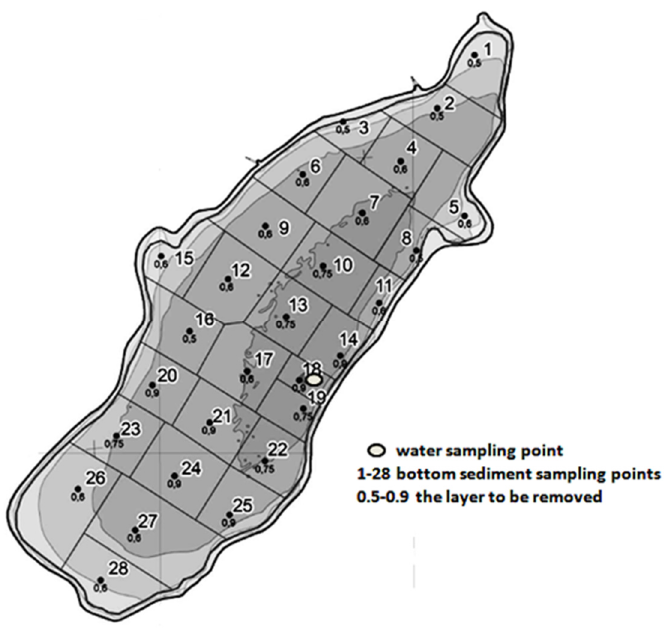
Figure 2. The spatial distribution of research points with the thickness of the sediment layer meant to mining.